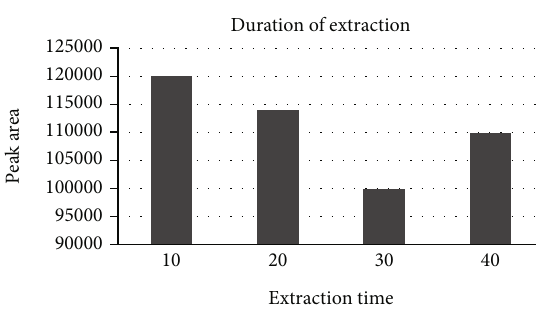
Figure 11: Rate of mixing.